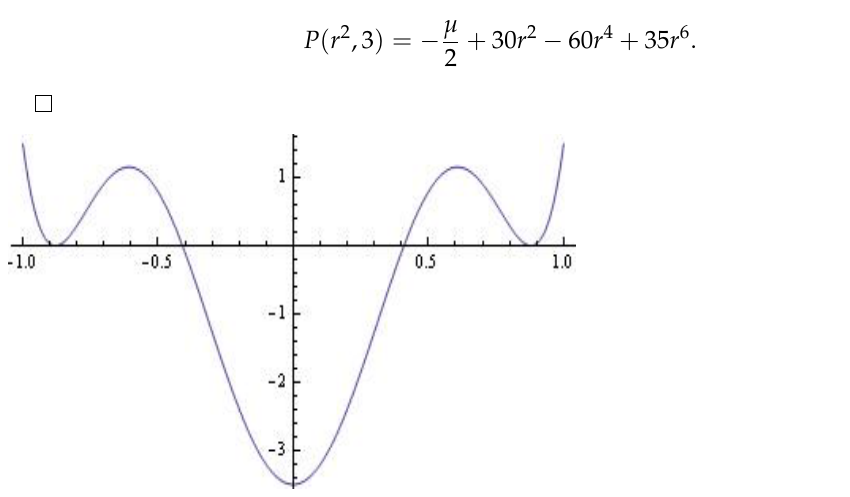
Figure 8. P ( r 2 ,3 ) for n = 7 and µ = 7.00805257. The roots are: 0.409106—simple and 0.879462—with multiplicity 2